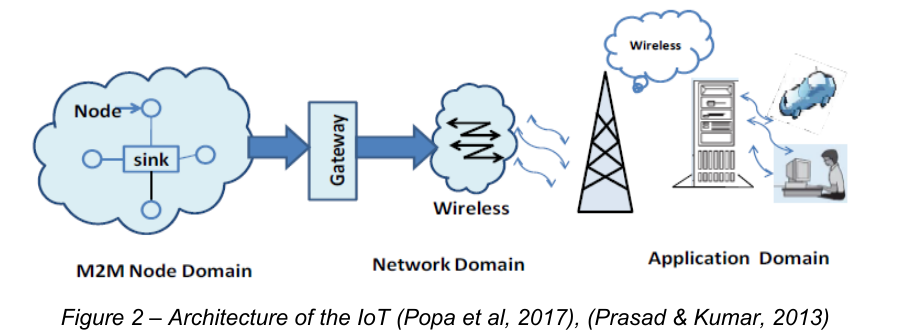
Рис . 2 – Архитектура интернета вещей (Popa et al, 2017), (Prasad & Kumar, 2013) Слика 2 – Архитектура интернета ствари (Popa et al, 2017), (Prasad & Kumar,